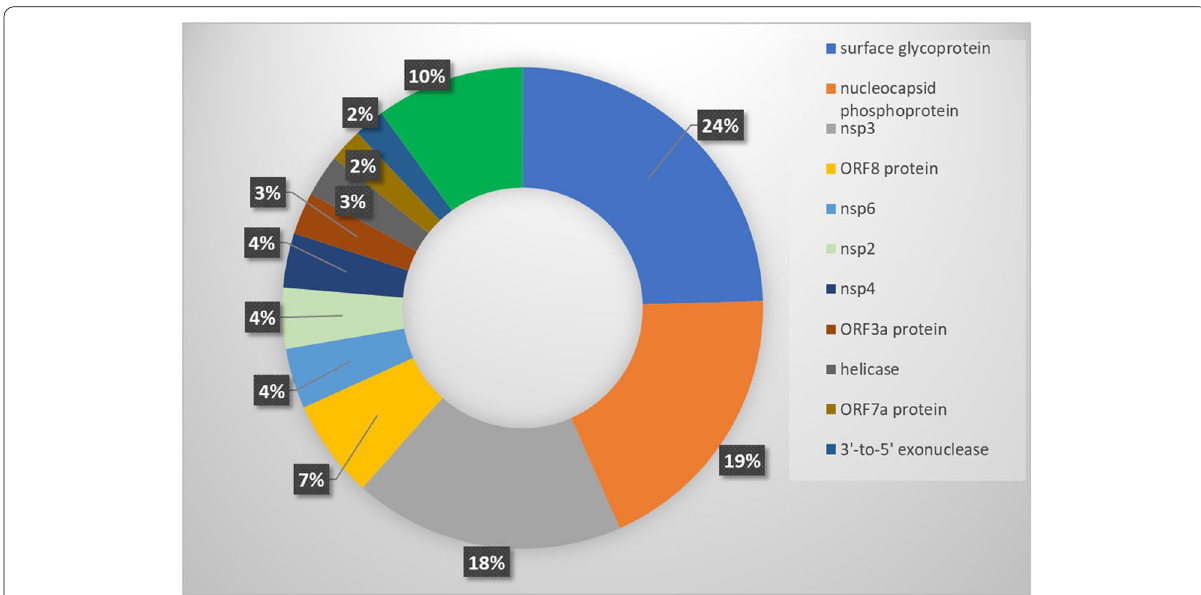
Fig. 3 Distribution of major hotspot mutant genes in 405,461 global samples with complete SARS-CoV-2 genome sequences. Complete genomes sequences from National Center for Biotechnology Information (NCBI) database were analyzed for top mutant genes as of August 4th, 2021, a total of 405,461 complete SARS-CoV-2 genomes from 88 countries were